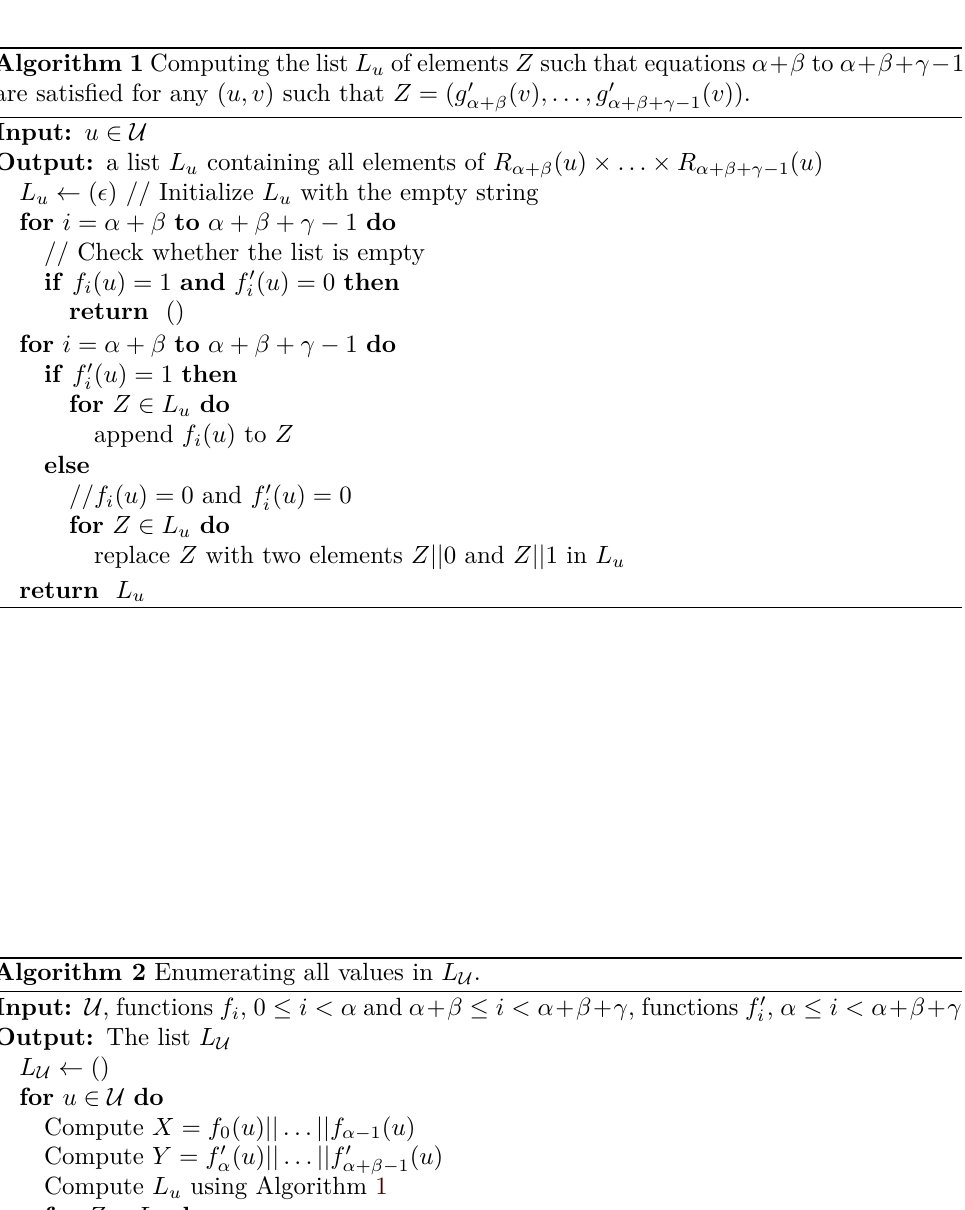
Algorithm 1 Computing the list L u of elements Z such that equations α + β to α + β + γ − 1 are satisfied for any ( u, v ) such that Z = ( g 0